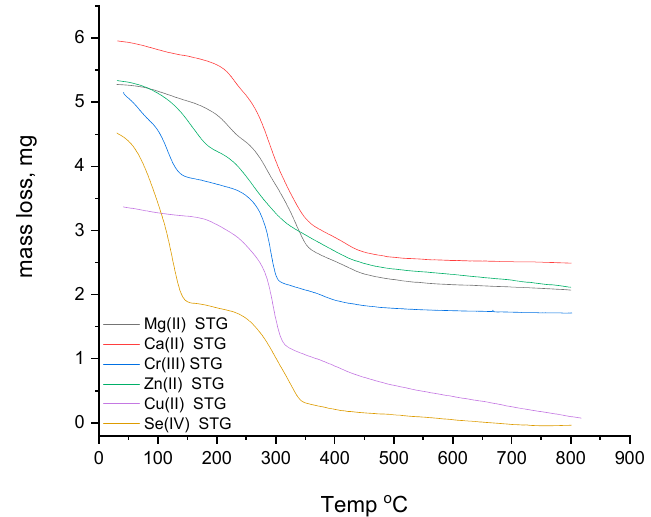
Figure 5. TGA curves of Mg(II), Ca(II), Cr(III), Zn(II), Cu(II), and Se(IV) STG complexes.